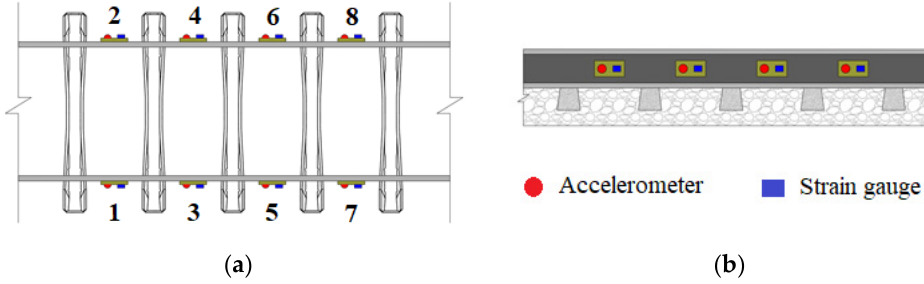
Figure 5. Virtual wayside monitoring system: ( a ) top view, ( b ) lateral view.